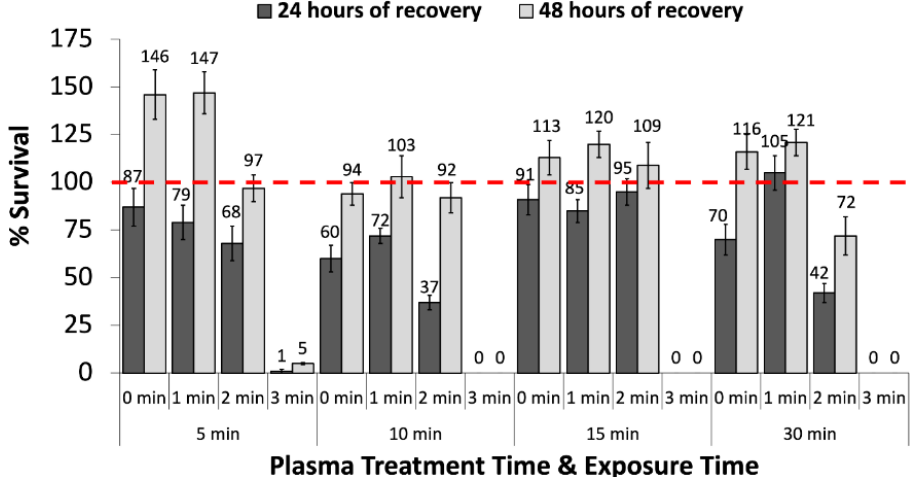
Figure 2. Cytotoxicity of plasma-treated NAC solution. Viabilities of EA.hy926 human endothelial cells after 24 and 48 h of recovery period when exposed to 1, 2, and 3-min plasma-treated NAC solutions for 5, 10, 15, and 30 min. The red dashed line represents a relative viability for the cells to 100% that were exposed to